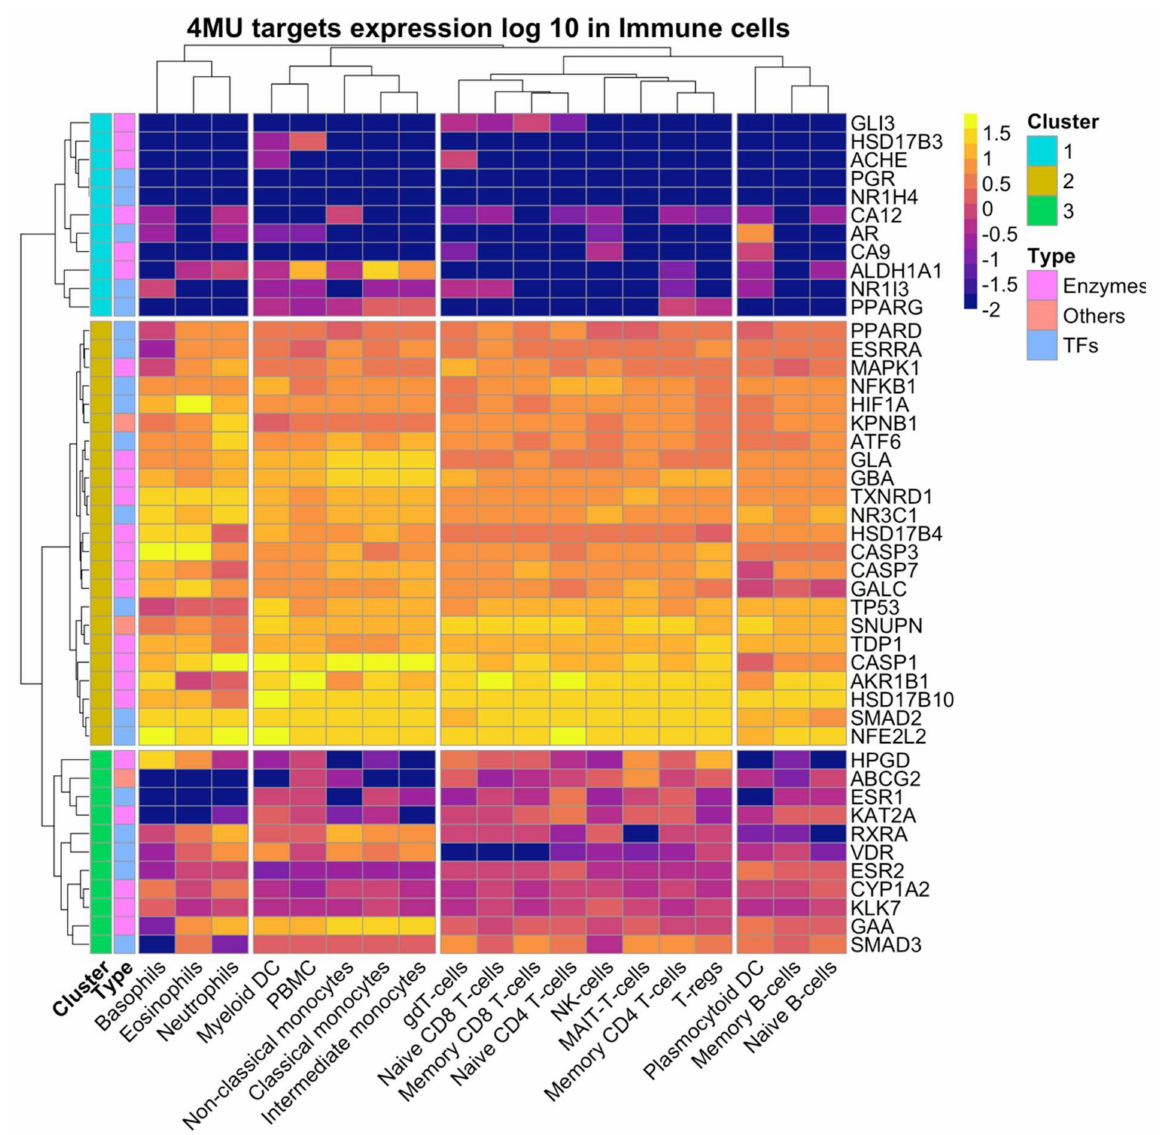
Figure 4. Expression of 4MU targets in the immune cells. Data were retrieved manually from the HPA RNA expression dataset from the Human Protein Atlas database. Data present in log 10 scale, − 2 value represent the absence of